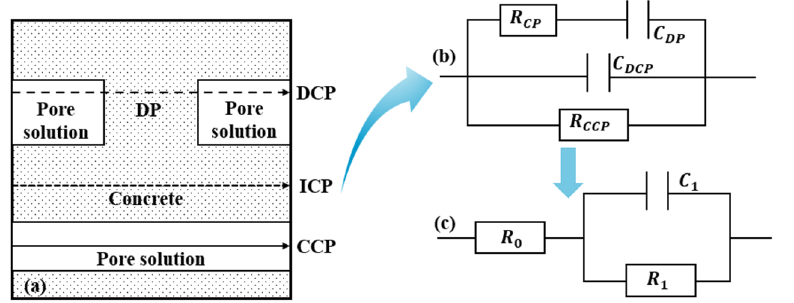
Figure 11. Equivalent circuit plot of concrete microstructure. ( a ) simplified model of concrete microstructure ( b ) equivalent circuit diagram ( c ) simplified equivalent circuit diagram.